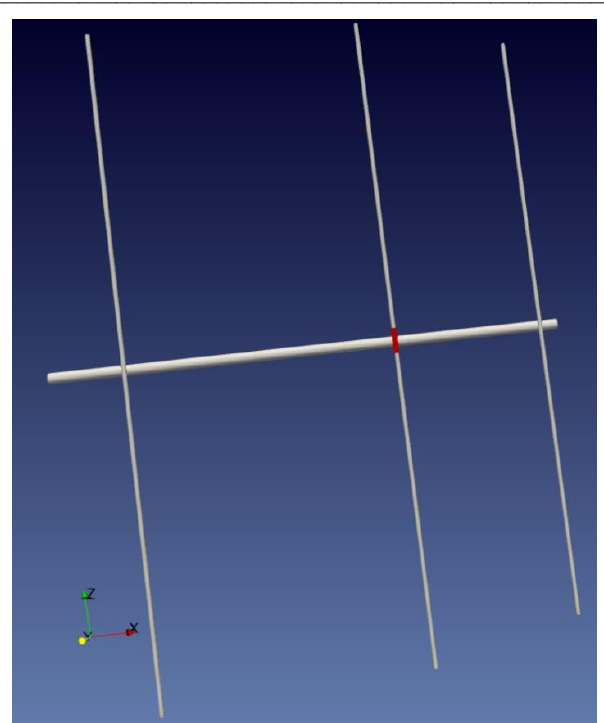
Fig. 5. Pictorial view of the three-element Yagi antenna.